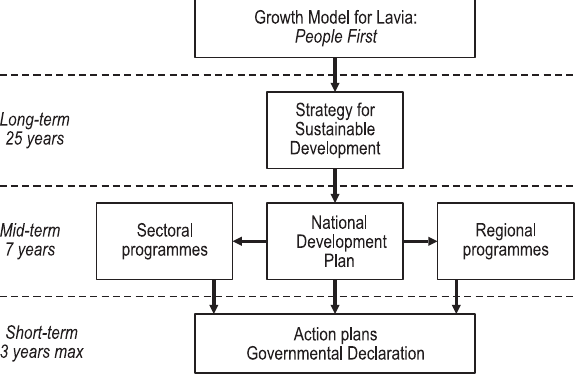
Fig. 3. Development planning system: hierarchy of